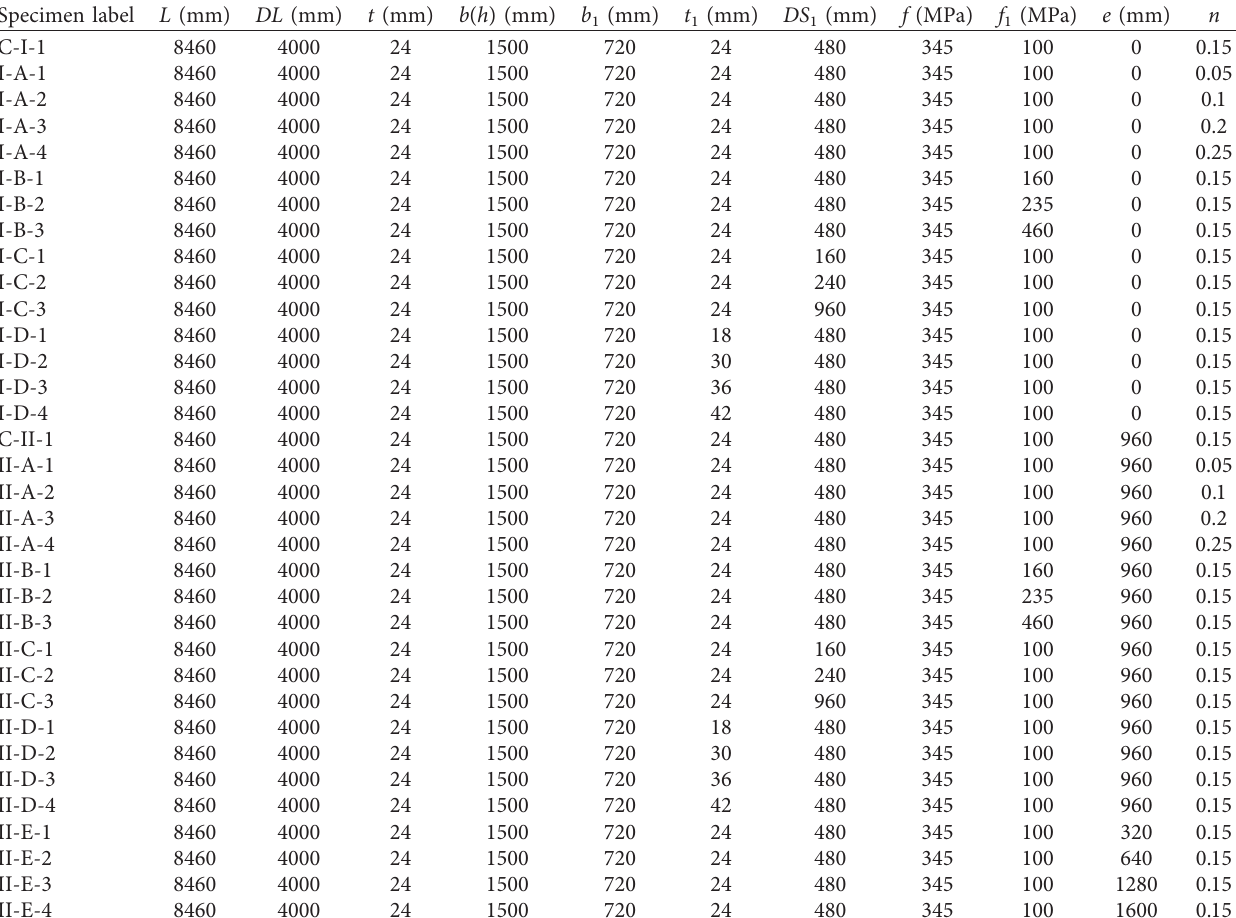
Table 5: The design parameters of pseudostatic